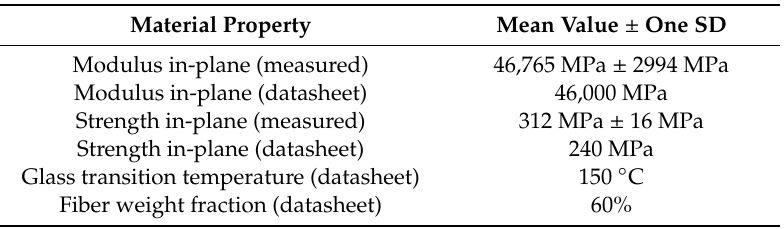
Table 1. Material properties of investigated C-SMC [18].